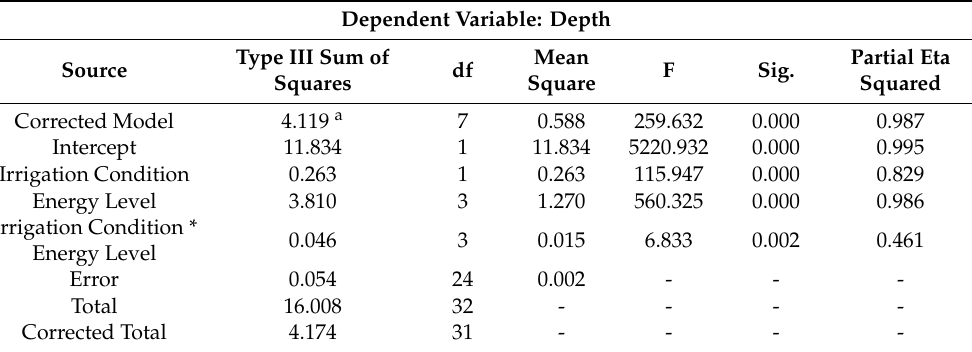
Table A5. Tests of Between-Subjects E ff ects.